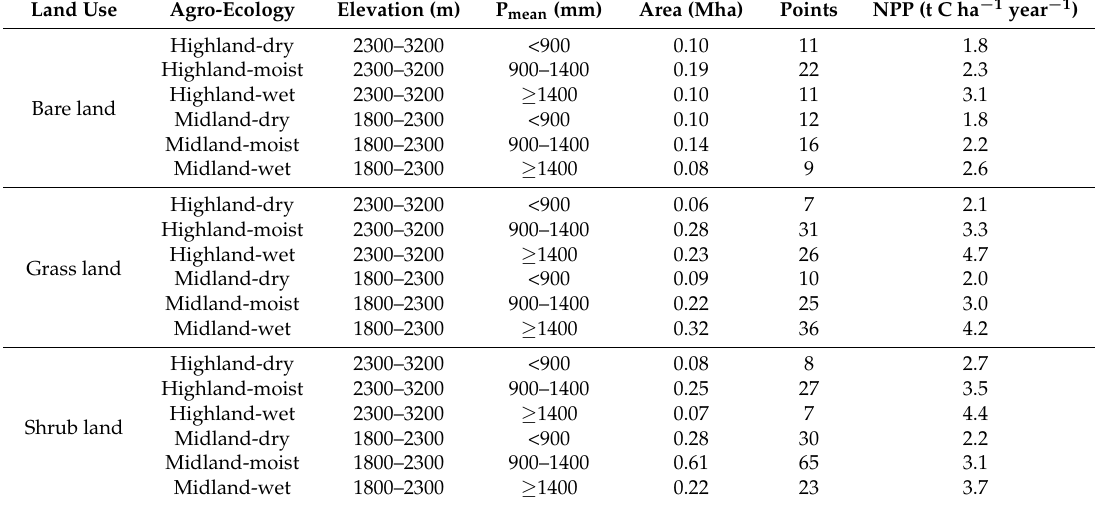
Table 2. Agro-ecological zones (Agro-ecology), Elevation ranges (Elevation), and Annual precipitation ranges (P mean ), area size of each agro-ecological zone in million hectare (Area), number of simulation points (Points), and annual NPP (10-year mean, years 91–100 after reforestation) from Biome-BGC simulations (unthinned) averaged over the simulation